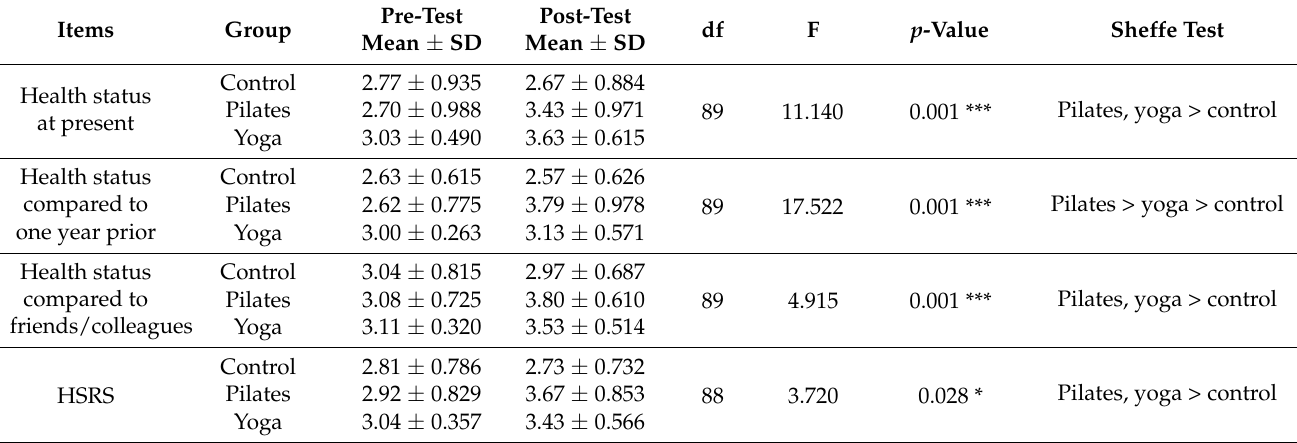
Table 7. Pre- and post-treatment HSRS across the three groups.